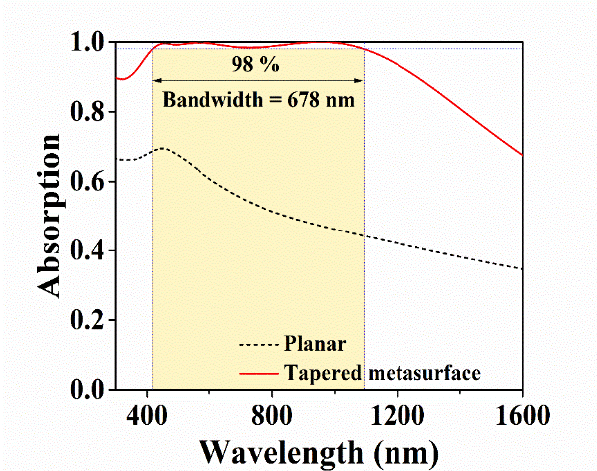
Figure 2. Absorption spectra for the proposed MA (red solid line) compared to its planar counterpart (black dashed line).